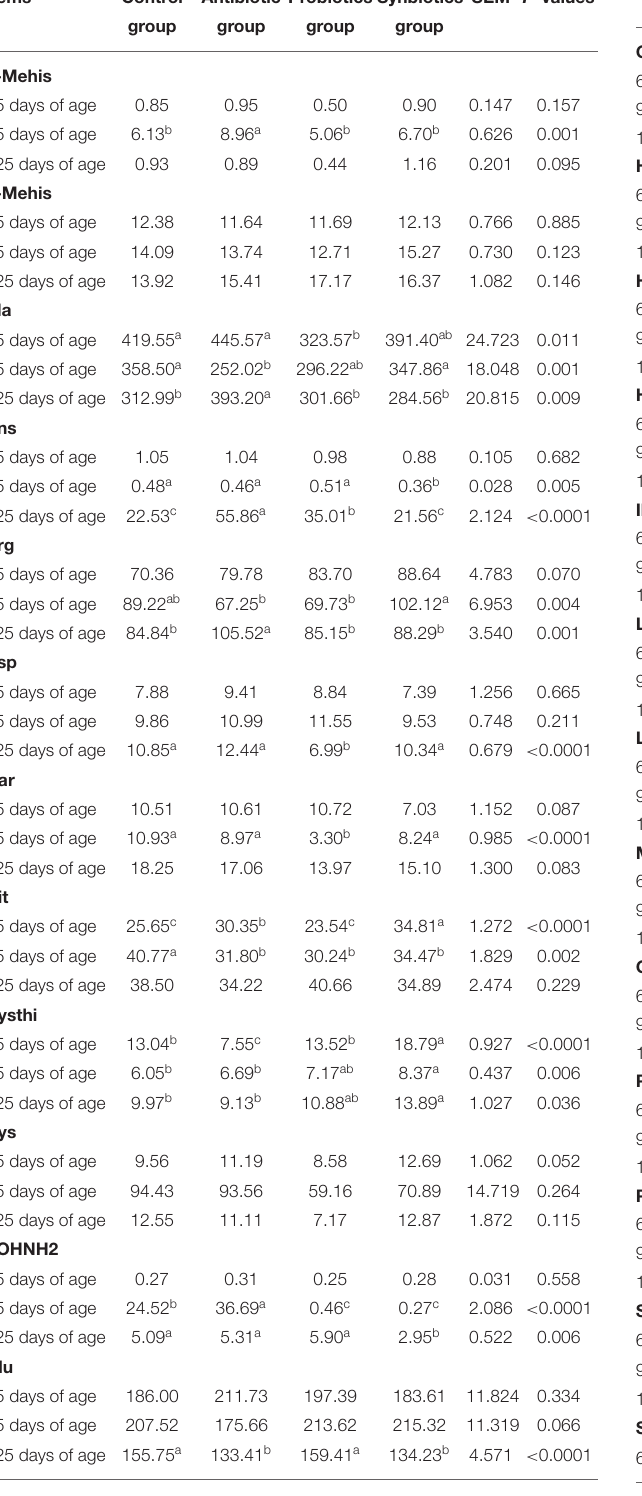
TABLE 7 | Effects of probiotics and synbiotics addition in sows’ diets on plasma-free amino acid of offspring pigs (nmol/mL).